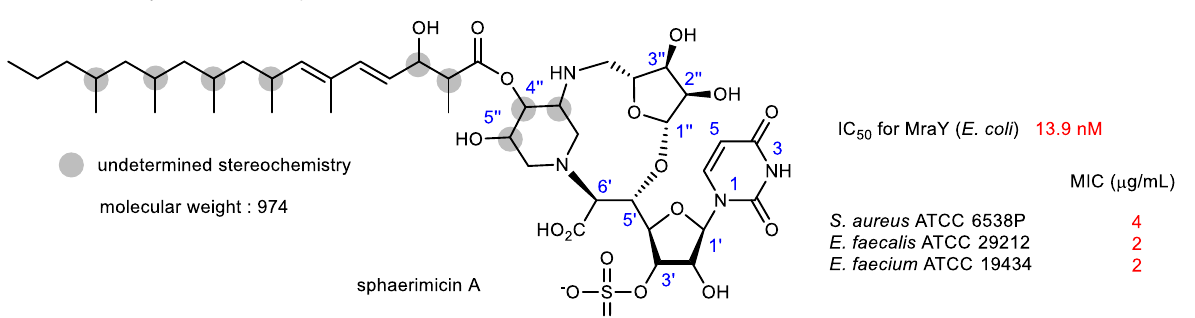
Fig. 1 | Peptidoglycan biosynthesis and MraY inhibitors. a A lipid cycle of peptidoglycan biosynthesis and b chemical structure of sphaerimicin A. IC 50 50% inhibitory concentration, MIC minimum inhibitory concentration, PBP penicillin-binding